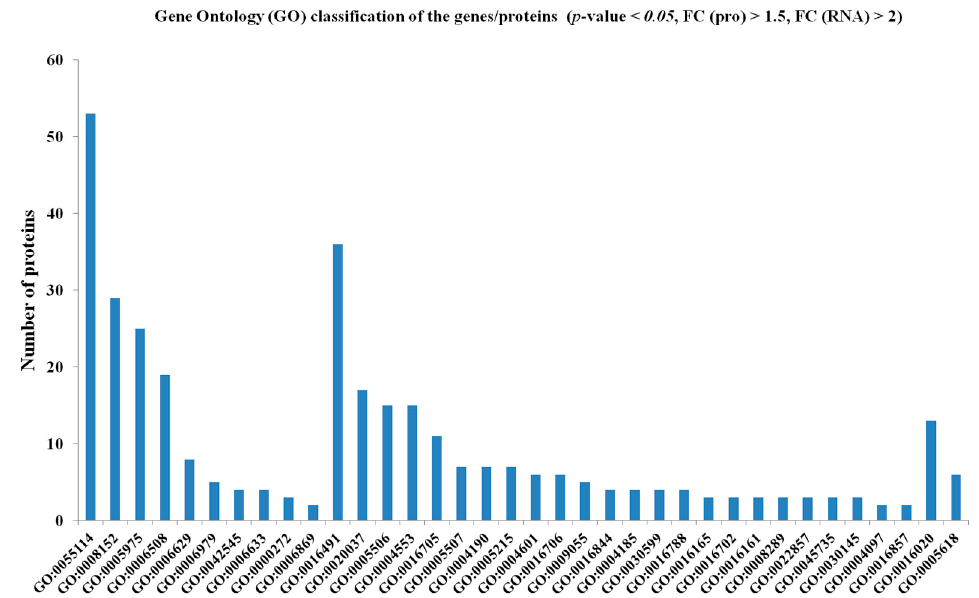
Figure 3. Gene Ontology (GO) classification of the genes/proteins whose transcript and protein levels were positively correlated ( p -value < 0.05, FC (pro) > 1.5, FC (RNA) > 2) during the pitaya fruit